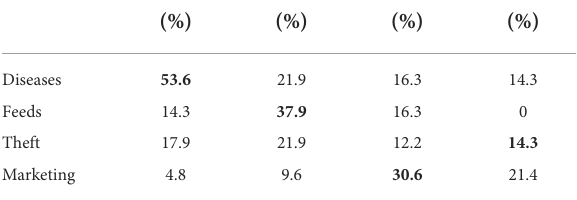
TABLE 3 Constraints to camel